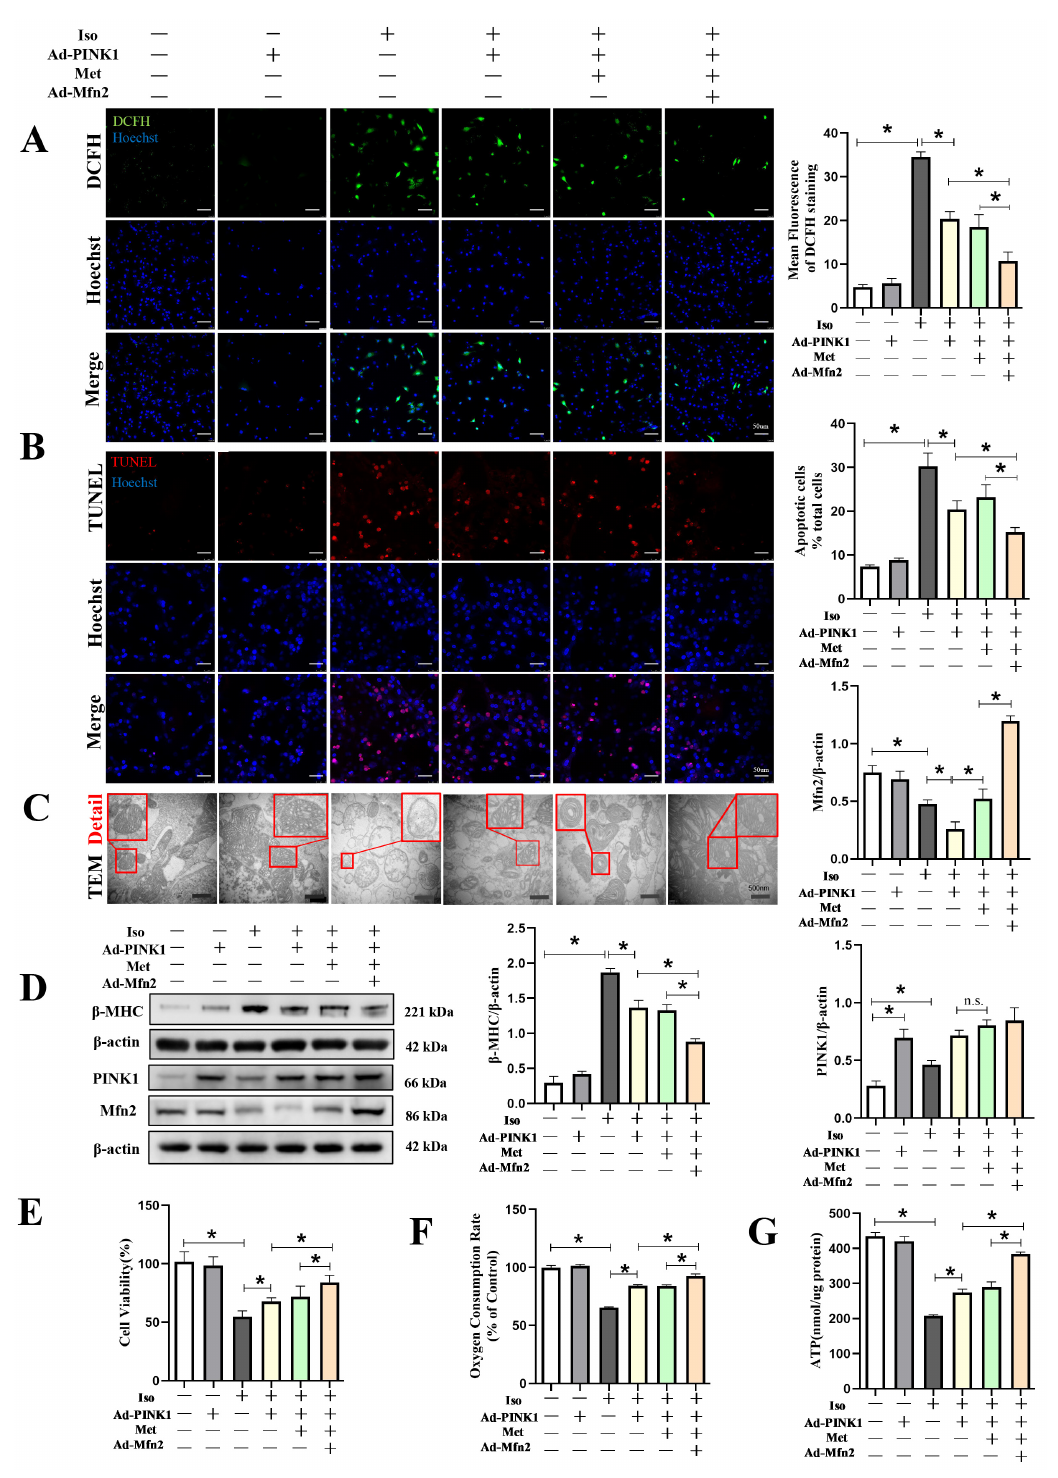
Figure 6. Mfn2 and Metformin in collaboration with PINK1 improved mitochondrial function